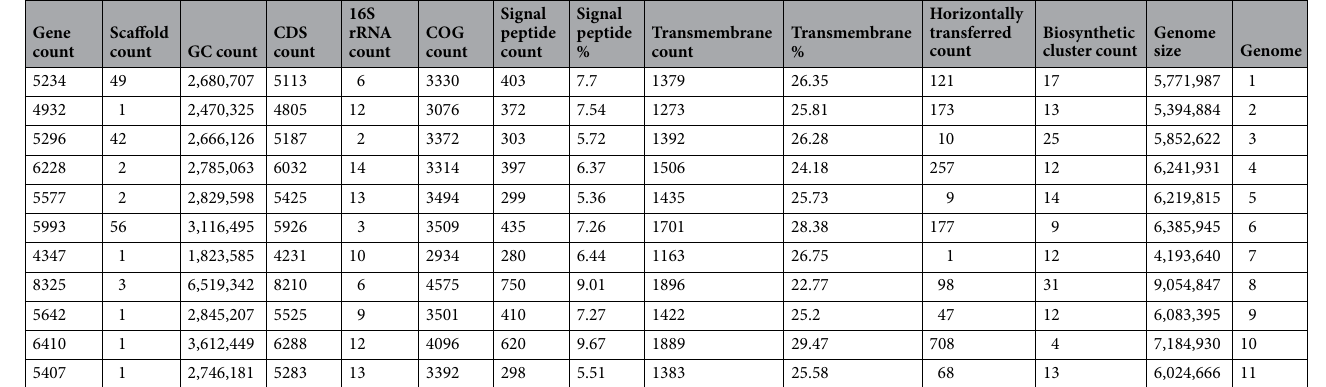
Table 3. Comparative genome features. 1. P. peoriae KCTC 3763 (NZ_AGFX01000000) 2. P. polymyxa E681 (NZ_CP048793) 3. P. peoriae IBSD35 ( NZ_PTJM01000000 ) 4. P. polymyxa SC2 (NC_014622) 5. P.